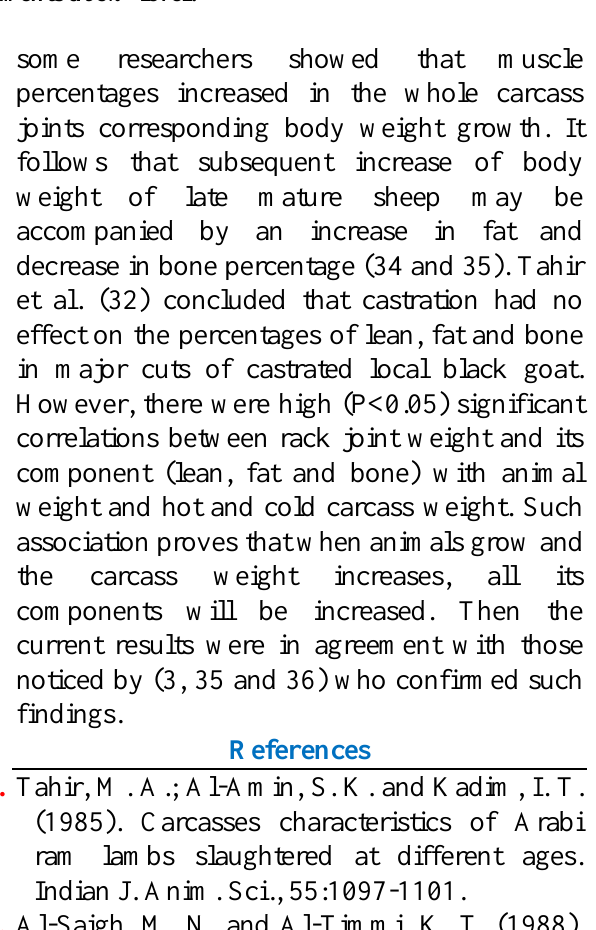
Different letters showed significant difference among treatments at 5%